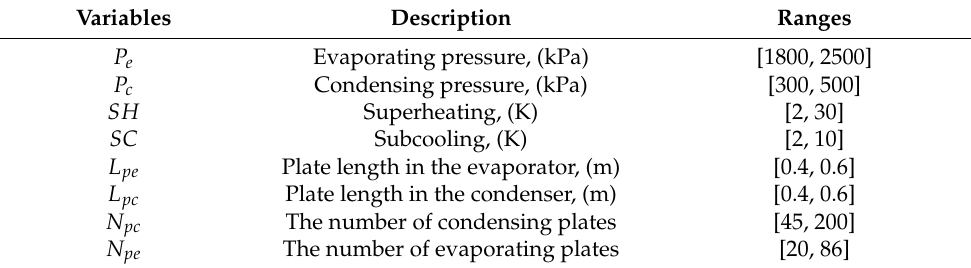
Table 5. The optimization range of the decision variables. Variables